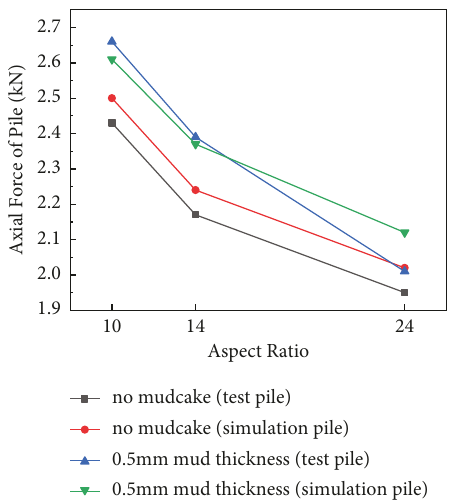
Figure 19: Curve of pile tip resistance and length-diameter ratio.